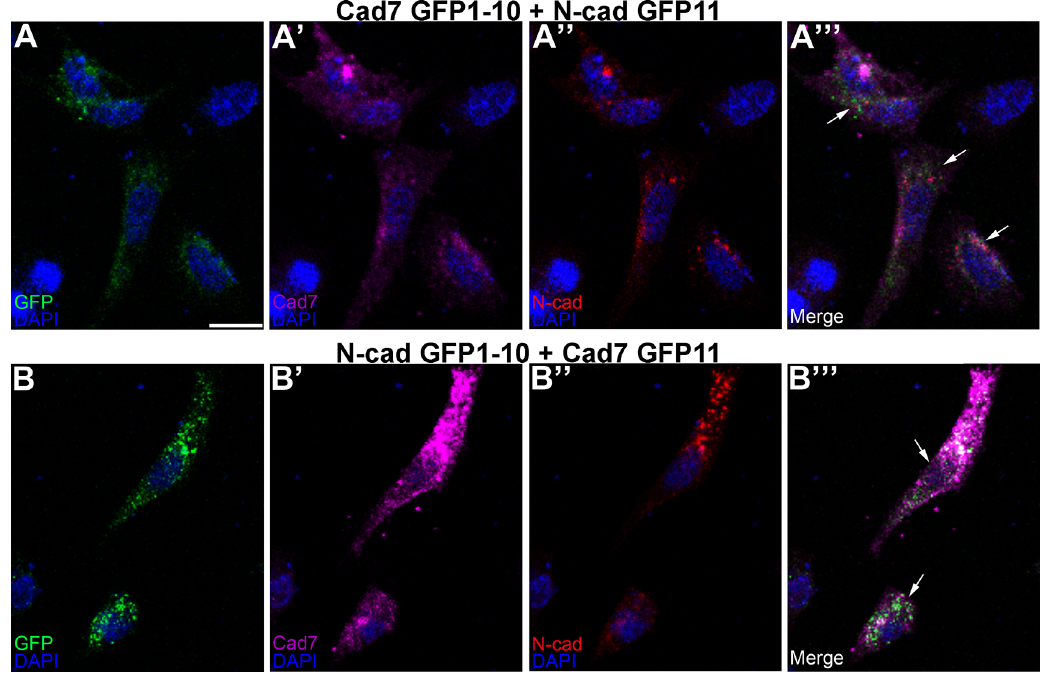
Figure 6. Different cadherin-expressing GRASP constructs possessing complementary GFP domains recon- stitute GFP in cis. Cad7 GFP1-10 and N-cad GFP11 (A-A ”’ ), or N-cad GFP1-10 and Cad7 GFP11 (B-B ”’ ), were co-transfected into CHO cells, followed by immunocytochemistry for Cad7 (A ’ , A ”’ , B ’ , B ”’ , purple) and N-cad (A ” , A ”’ , B ” , B ”’ , red). GFP fluorescence was also examined in the appropriate microscope channel (488, A, A ”’ , B, B ”’ , green). Arrows point to GFP fluorescence in transfected cells, indicative of physical interactions between each split GFP- expressingcadherin.DAPI(blue),cellnuclei.Scalebarin(A)is50 μ mandappliestoallimages.N=8replicatesforboth treatments. GFP, green fluorescent protein; GRASP, GFP reconstitution across synaptic partners; CHO, Chinese hamster ovary; N-cad, neural cadherin; Cad7, Cadherin-7.